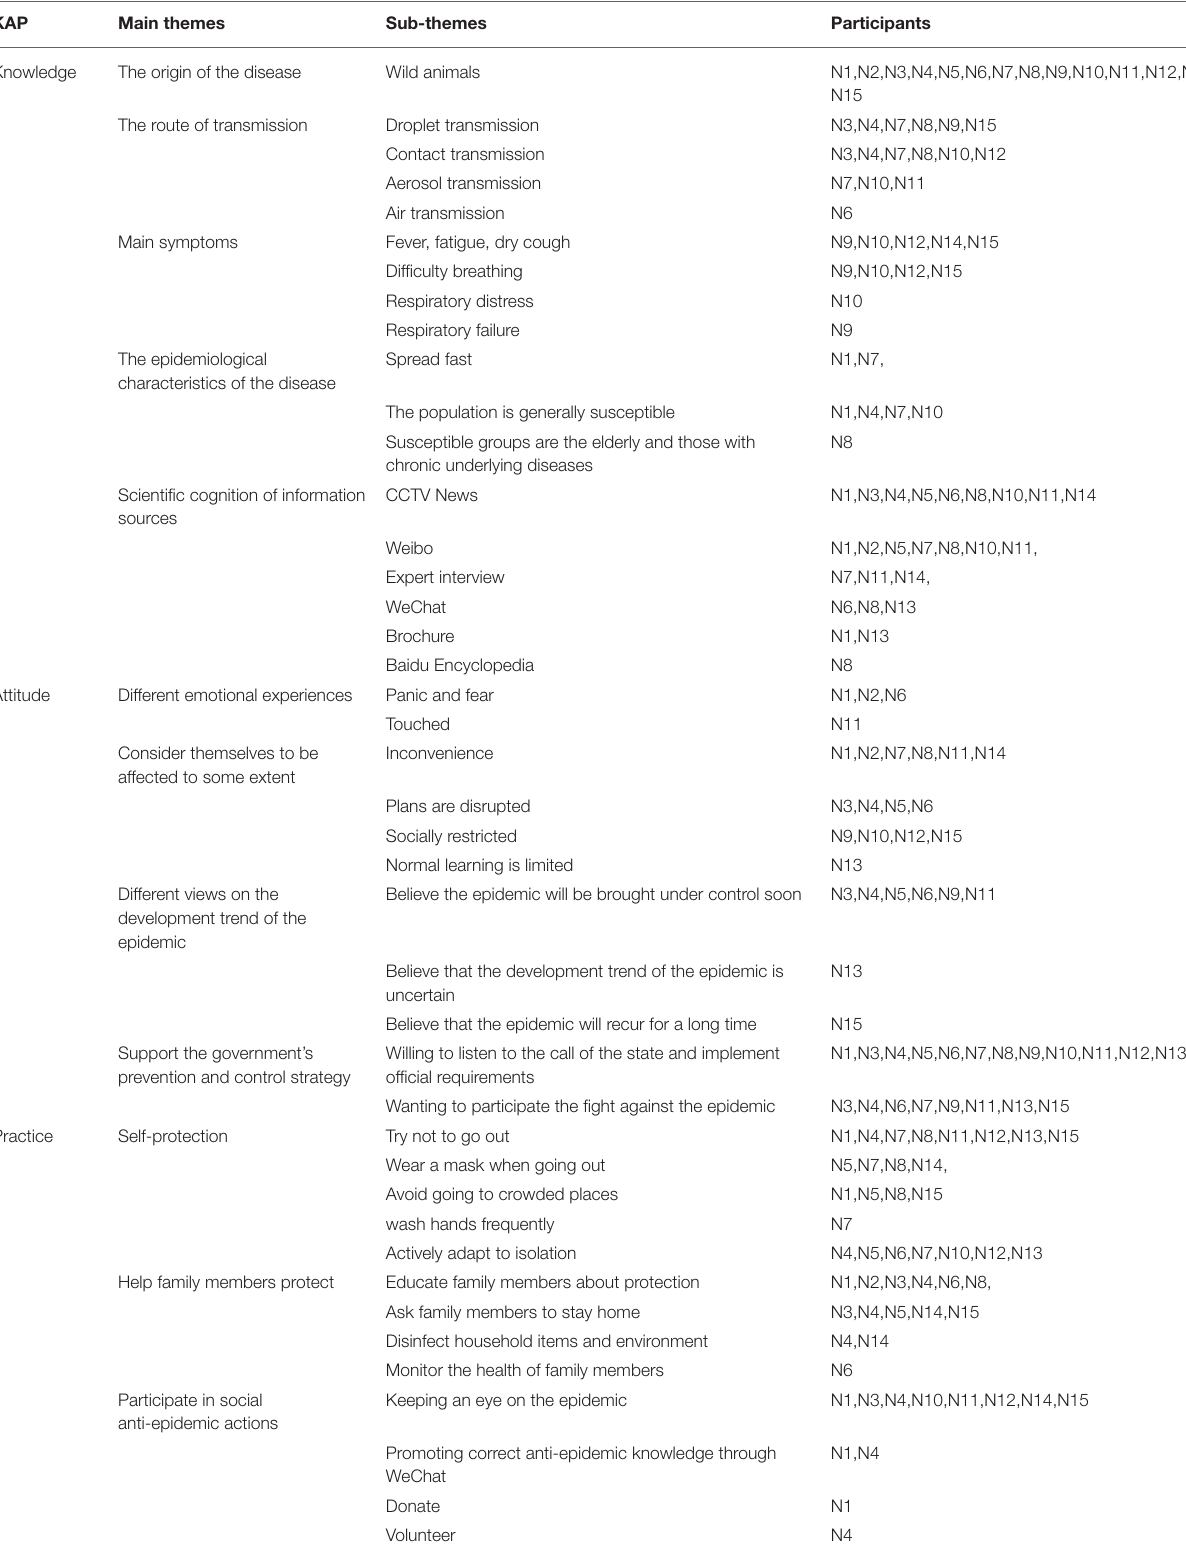
TABLE 1 | Main themes and sub-themes from the